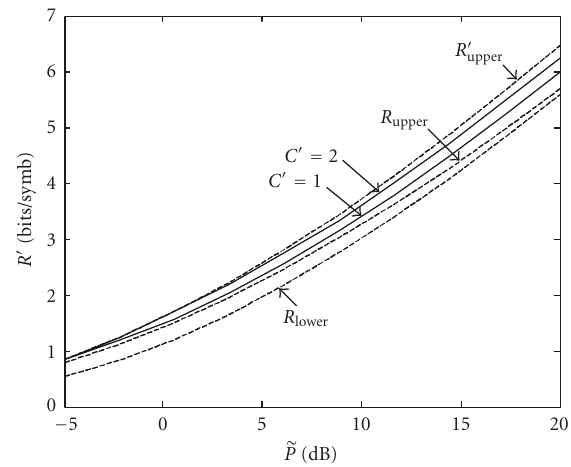
Figure 8: Achievable rate (21) with intracell conferencing versus the transmitted power per cell (cid:4) P along with the lower bound R lower (4) and the upper bounds R upper (6) (corresponding to intercell (20) (intracell conferencing). Note that conferencing) and R (cid:10) upper if C (cid:10) ≥ R (cid:10) ( α = 0 . 6, C (cid:10) = 1,2 and J = 2 MSs per R (cid:10) = R (cid:10) upper upper